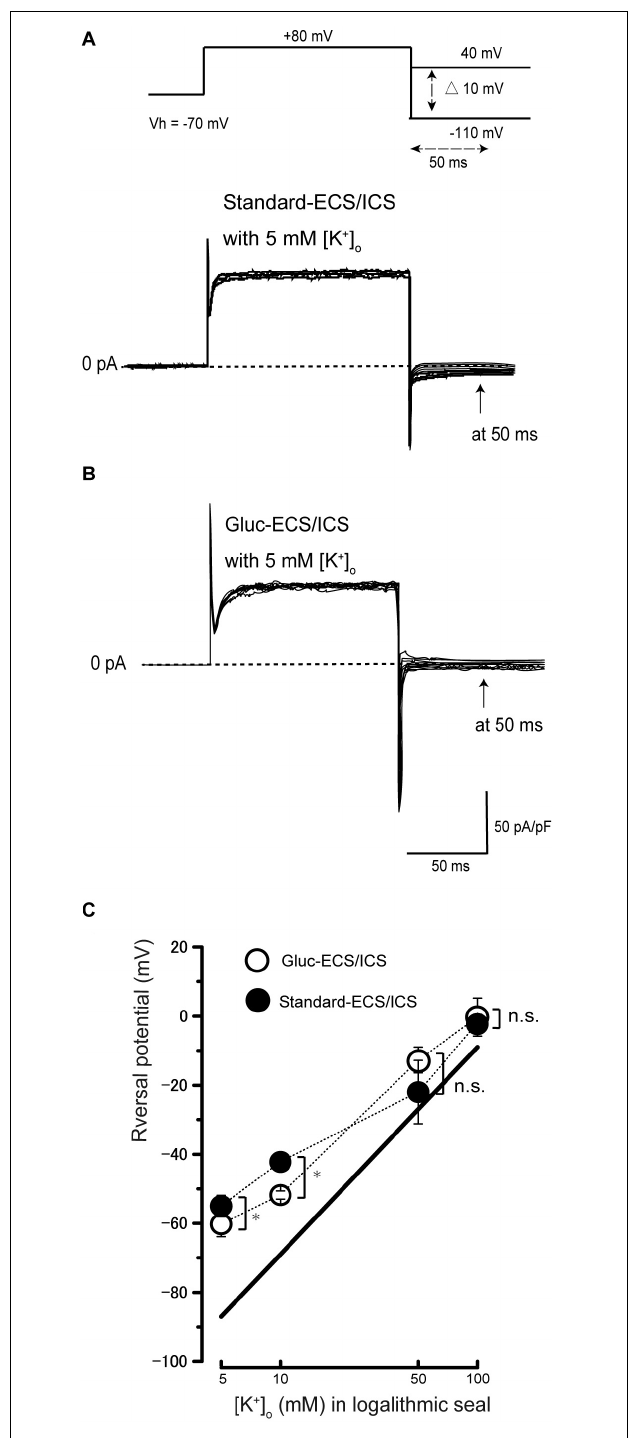
FIGURE 3 | Tail current analysis of outward currents in human cementoblasts. (A,B) Representative current traces recorded from standard-ECS/ICS [lower traces in panel (A) ] and gluc-ECS/ICS (B) are shown. Currents were elicited by applying voltage in steps from a Vh of –70 mV to +80 mV before hyperpolarizing in 10 mV increments ranging from –110 to +40 mV [upper traces in panel (A) ]. To analyze the values of reversal potential, we